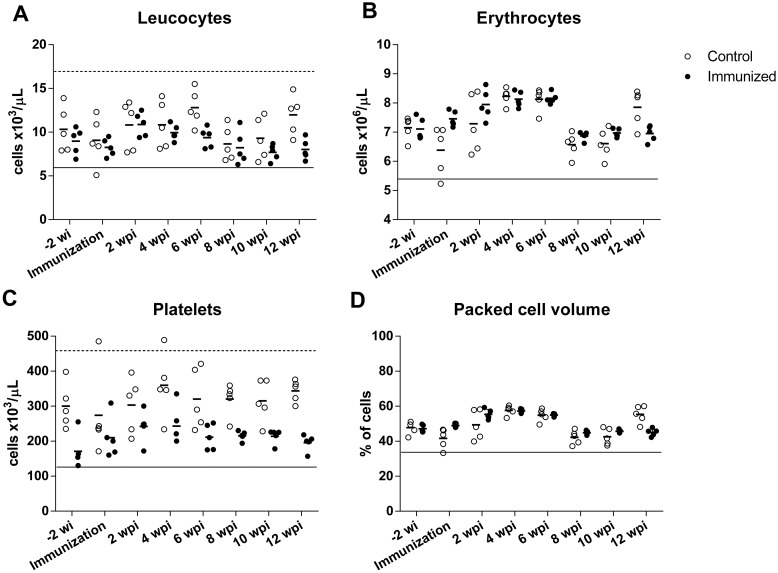
Hematological parameters of dogs immunized with alginate-encapsulated B. ovis ΔabcBA (immunized) or inoculated with sterile alginate capsules (control).Horizontal lines indicate the mean numbers of leucocytes (A), erythrocytes (B), platelets (C) and packed cell volume (D), and individual values are indicated by open dots (Control) or closed dots (Immunized). Reference values are indicated by a dashed line (upper limit) and a continuous line (lower limit).